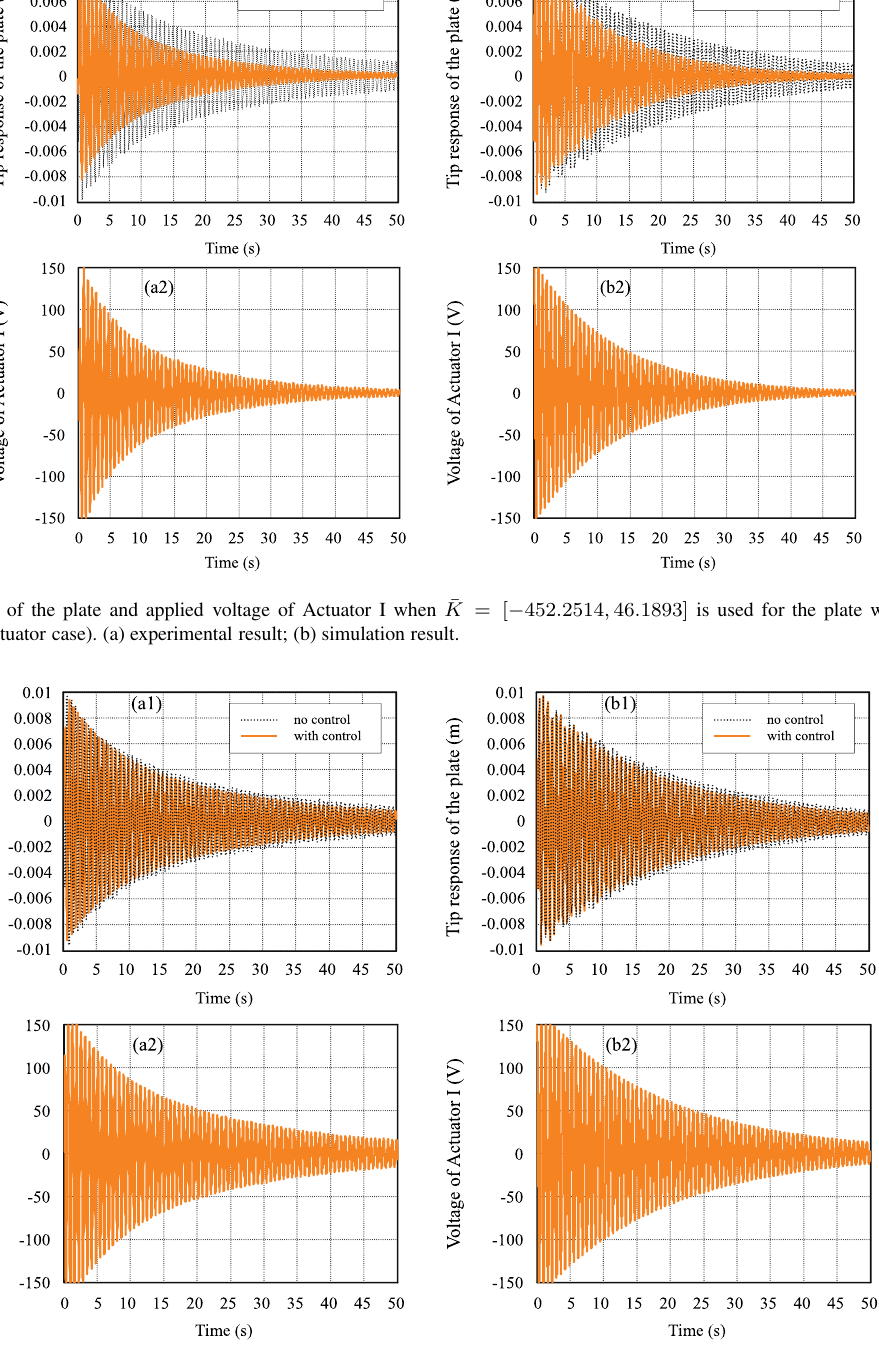
Fig. 12. Response of the plate and applied voltage of Actuator I when ¯ K = [ − 452 . 2514 , 46 . 1893] is used for the plate with time delay τ = 0 . 17 s (one actuator case). (a) experimental result; (b) simulation